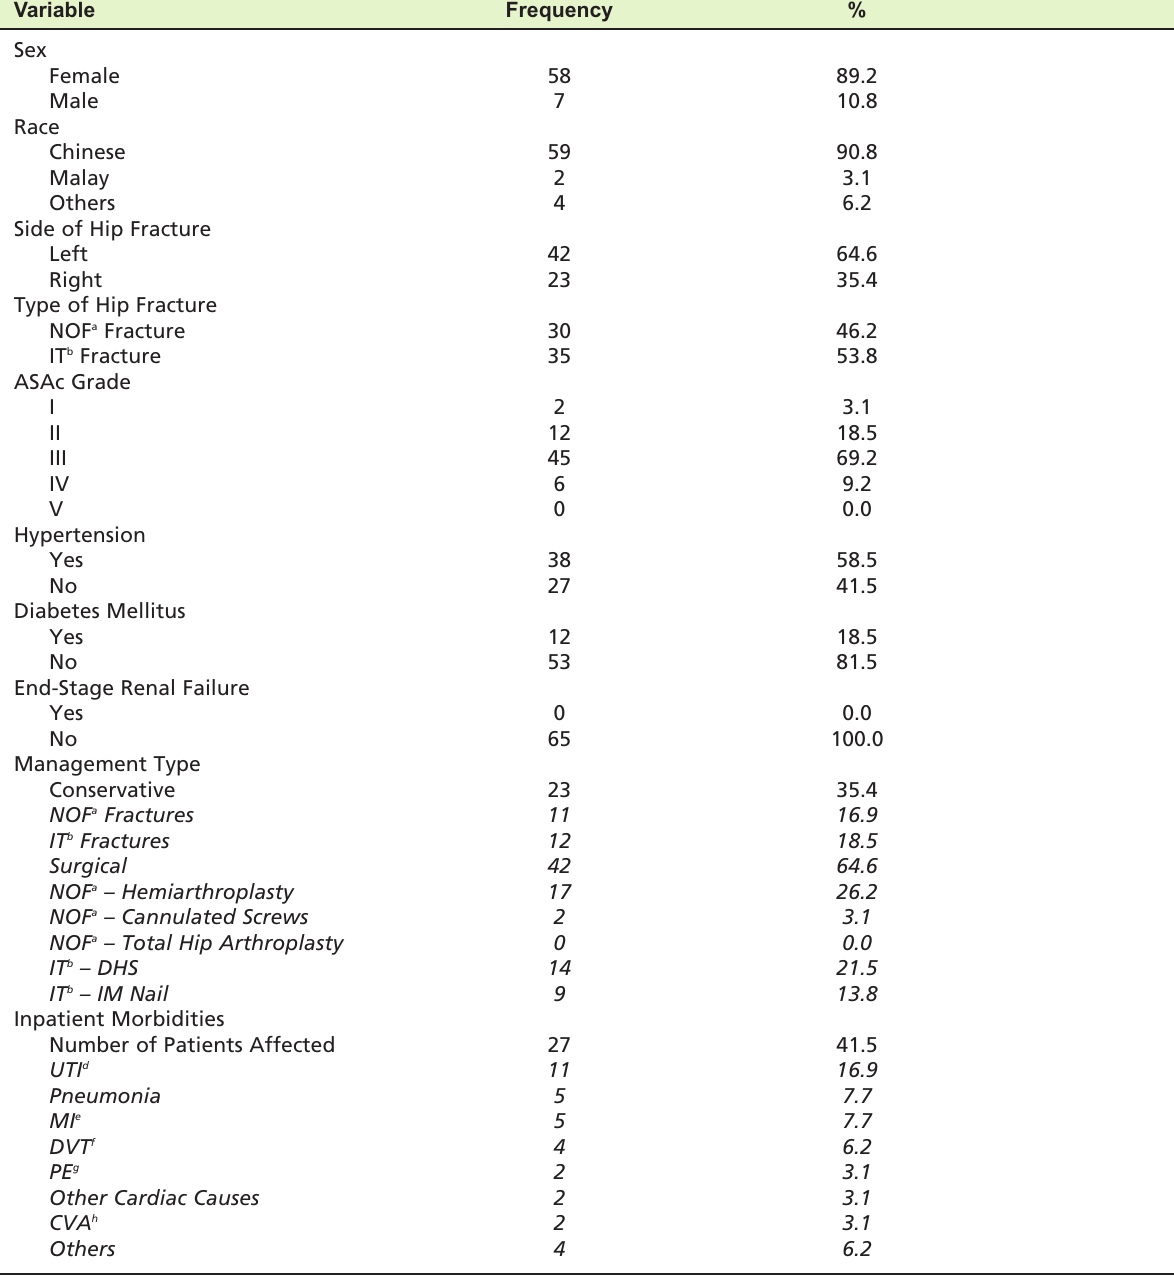
Descriptive statistics for categorical Table III: